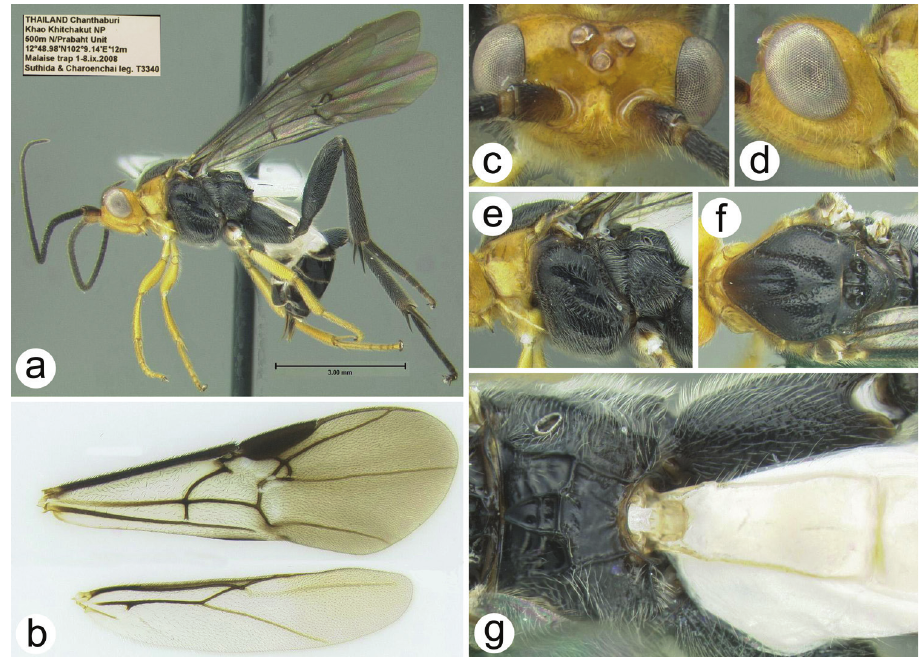
Figure 10. Zelodia nopadoli sp.n. a lateral habitus b wings c dorsal head d lateral head e lateral meso- soma f dorsal mesosoma g dorsal propodeum and